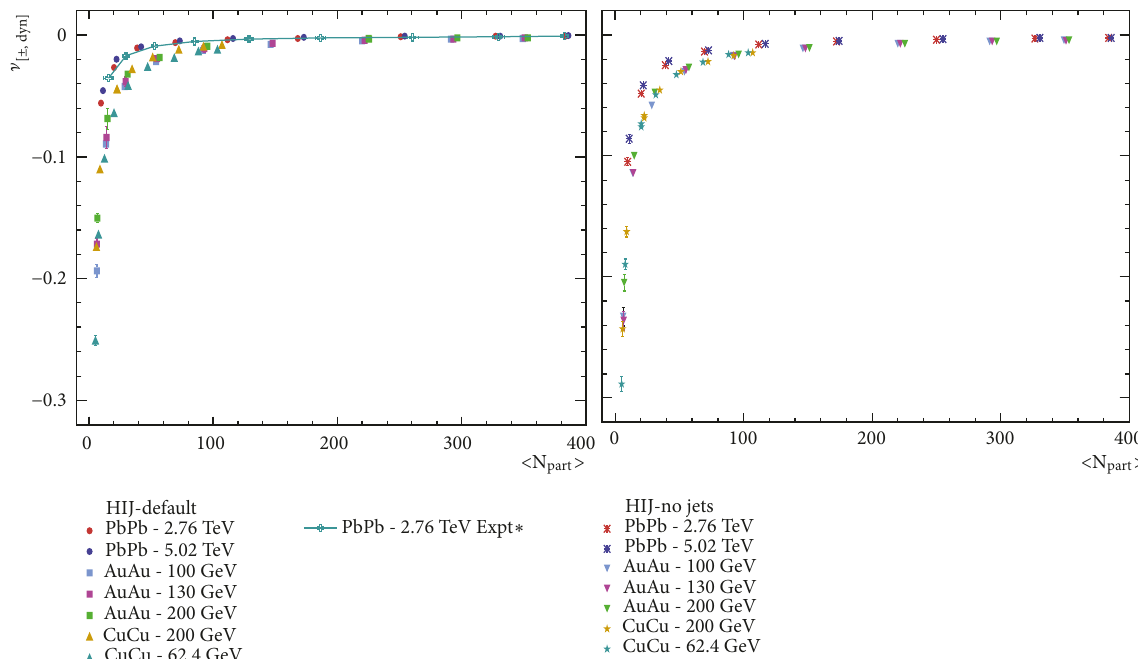
Figure 1: Dependence of net charge fluctuations ] [+−,𝑑𝑦𝑛] on the number of participating nucleons, 𝑁 𝑝𝑎𝑟𝑡 , for the HIJING events with jets/minijets on and off. Experimental results for Pb-Pb collisions at 2.76 TeV are also shown [data from [17]].